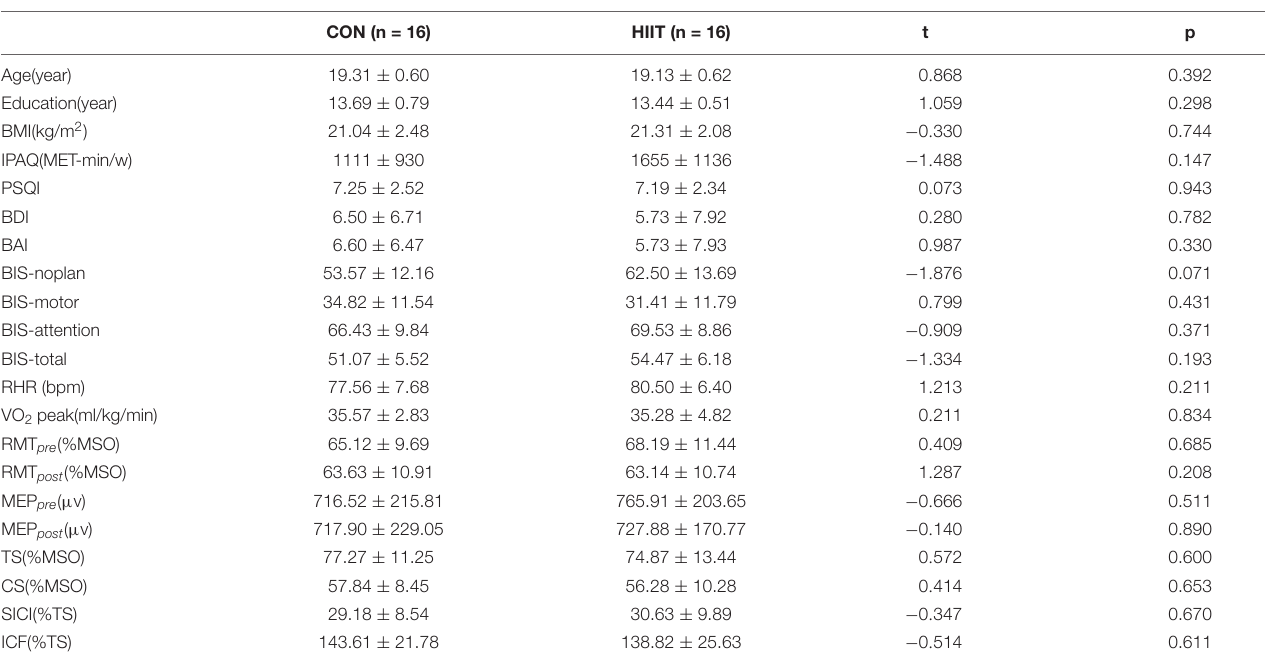
TABLE 1 | Demographic information and Baseline TMS parameters (X ±